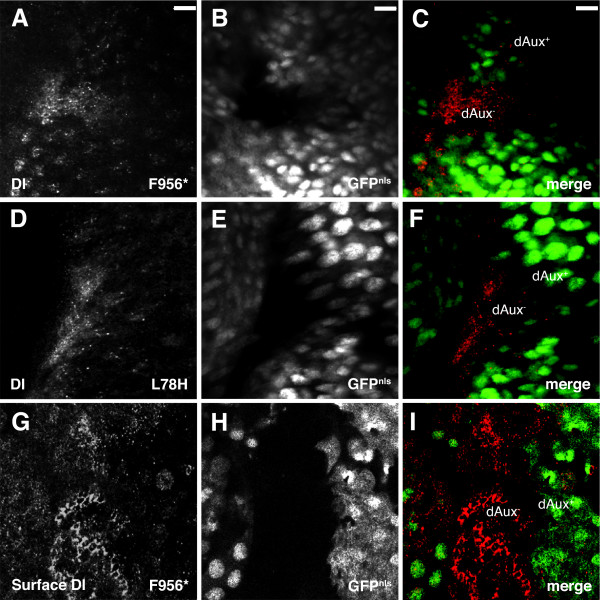
dAux mutant cells show an accumulation of Dl at the surface. Confocal images of (A-C and G-I) Act5C>FLP/+; FRT5-5Z3515, dAuxF956*/FRT5-5Z3515, ubi-GFPnls and (D-F) Act5C>FLP/+; FRT5-5Z3515, dAuxL78H/FRT5-5Z3515, ubi-GFPnls eye discs stained for Dl (red). In panels A through F, the Dl staining was performed in the presence of detergent. In contrast, the Dl staining in G- I was performed under non-permeabilized conditions, thereby detecting only Dl proteins at the cell surface. dAux mutant cells are indicated by the absence of nuclear GFP. Scale bar, 10 μm.